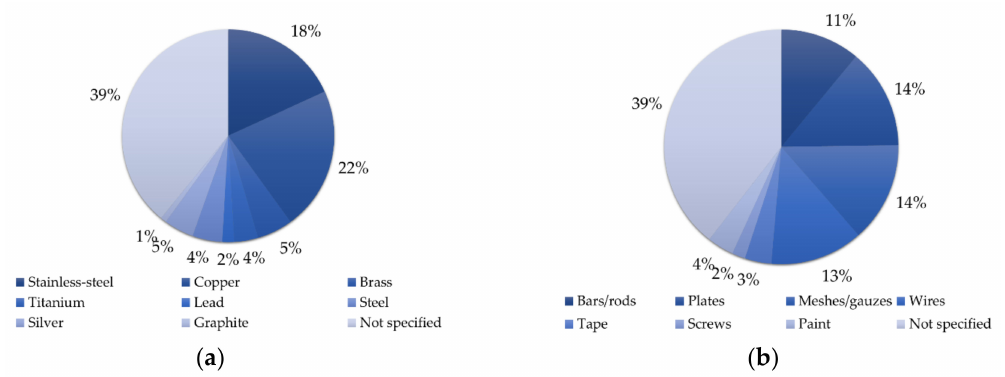
Figure 3. ( a ) Percentages of papers reporting DC and AC measurements; ( b ) Percentages of papers reporting 2- and 4-electrode DC / AC measurements.